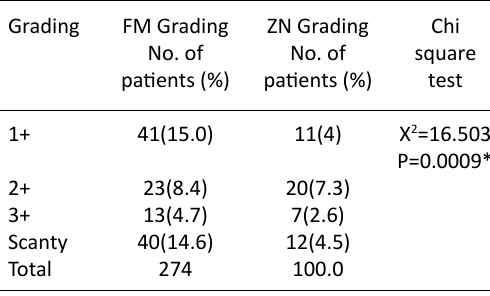
Table 4. Difference in grading score Grading FM Grading